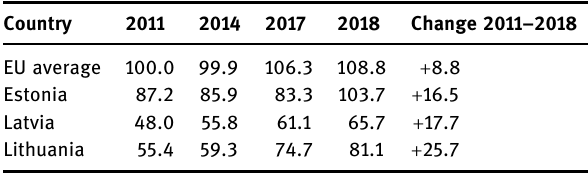
Table 1: EIS Summary Index for the period 2011 – 2018